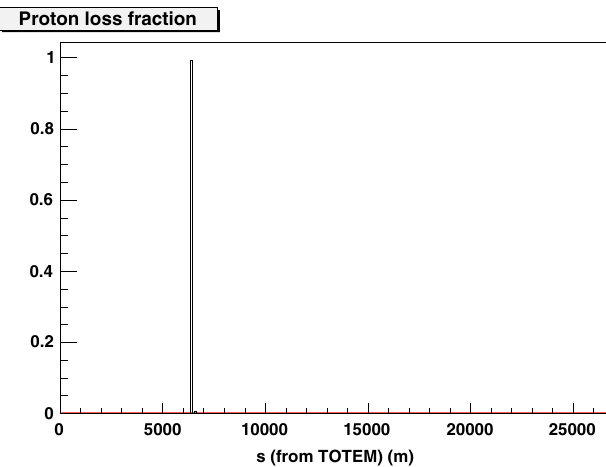
FIG. 13. (Color) The proton loss map around the ring for a quench in MB.B12L5.B1. The calculation was made for a 7 TeV stored beam with collision optics. The spike corresponds to loss on a secondary collimator.